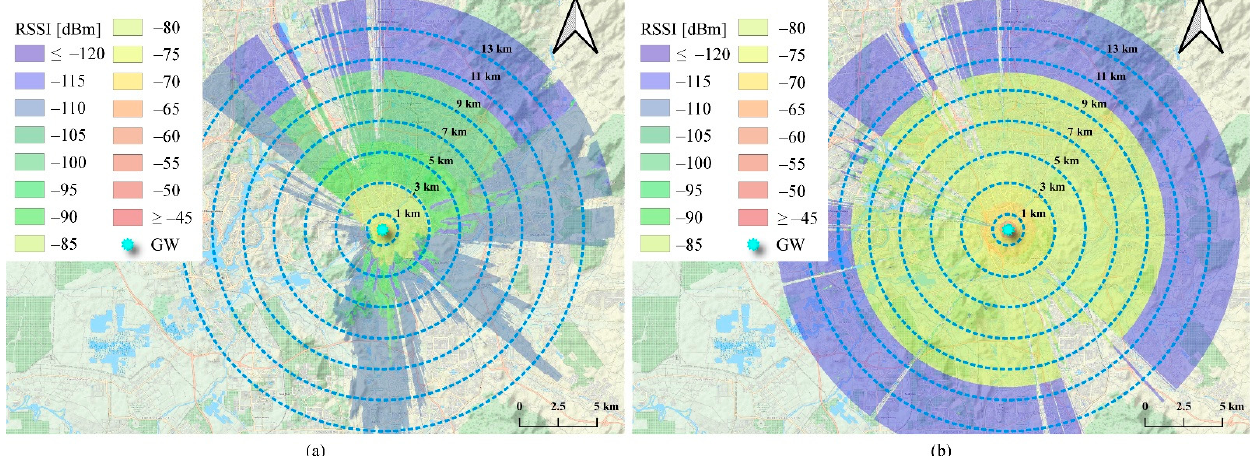
Figure 11. Heatmap of LoRaWAN ® coverage at UKM campus based on Cloud-RF ® PL simulations. ( a ) LoRaWAN ® coverage based on the ITM PL model. ( b ) LoRaWAN ® coverage based on the ECC-33 PL model.